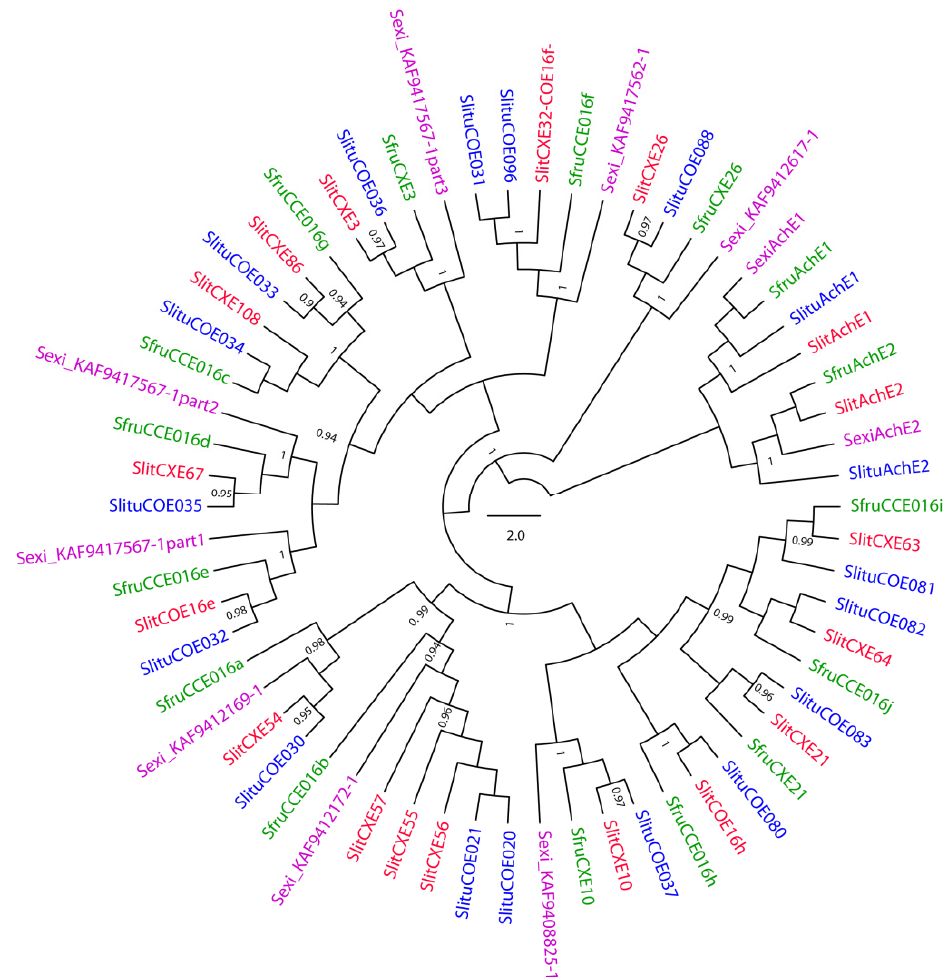
Figure 4. Maximum-likelihood phylogeny of spodopteran CCEs from Clade (016) and acetylcholinesterases (AChEs). The tree was built from amino-acid sequences of CCE repertoires of S. littoralis (branches colored in red), S. frugiperda Corn strains (green), S. litura (blue), S. exigua (purple). Sequences from [1,28] for S. litura and S. frugiperda , respectively. For S. littoralis , from [52,55] and new sequence from our RNAseq database (Table S1). For S. exigua , GenBank numbers were inserted the sequence name, SexiAChE1 (AZB49078.1) and SexiAChE2 (AZB49079.1). Likelihood-ratio test values are only indicated in the internal nodes defining orthogroups, when aLRT > 0.9. The scale bar represents 0.2 expected amino-acid substitutions per site.